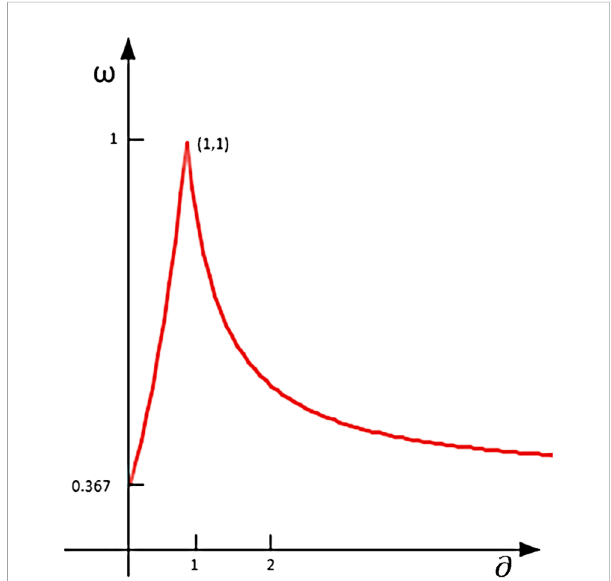
FIGURE 2 Variation curve of the inertia weight factor ( w ) according to the change rate of the objective values ( ∂ ). It can be observed from Figure 2 that w t +1 j increases with the increase of .. then 0 ≤ ∂ < 1. The large ∂ indicates that the objective values calculated by two adjacent iterations are close, and the diversity of particles is decreased. Increasing w expands the local search to a much broader space. When ∂ approaches 0, w is near 0.367. When ∂ ≥ 1. w decreases with the increase of ∂ . A bigger ∂ indicates a bigger difference between the objective values calculated by two adjacent iterations. Decreasing w increases the search intensity of particles. When ∂ approaches either 0 and in fi nity, w is near 0.367.